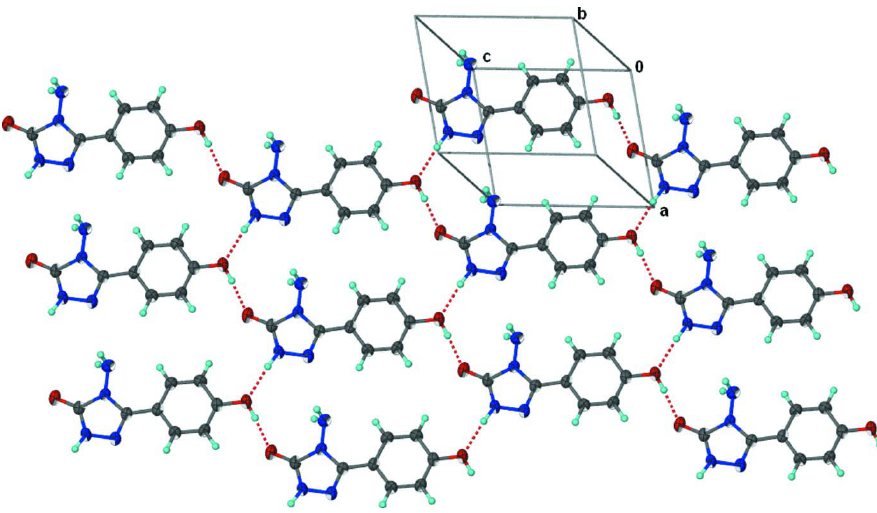
and N–H hydrogen bonds. hydroxy triazolyl